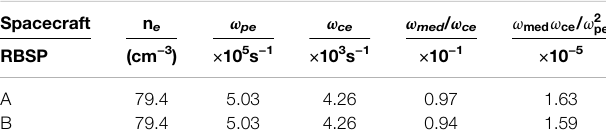
TABLE 2 | Average plasma and normalized wave parameters during the event interval. ω med is the median wave angular frequency calculated using f median from Table 1 .